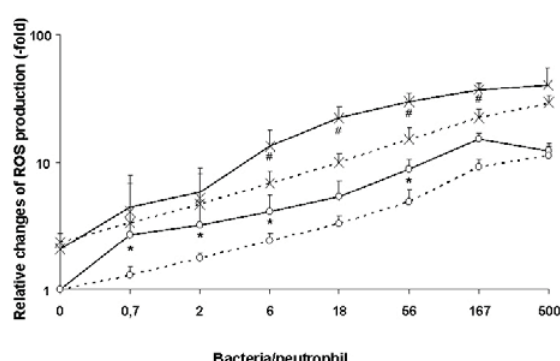
Figure 2. A graph showing dose dependant changes of PMA stimulated ROS production in peripheral blood neutrophils of COPD patients (rhombs) and HI (quadrates) according to basal conditions (100% RPMI).